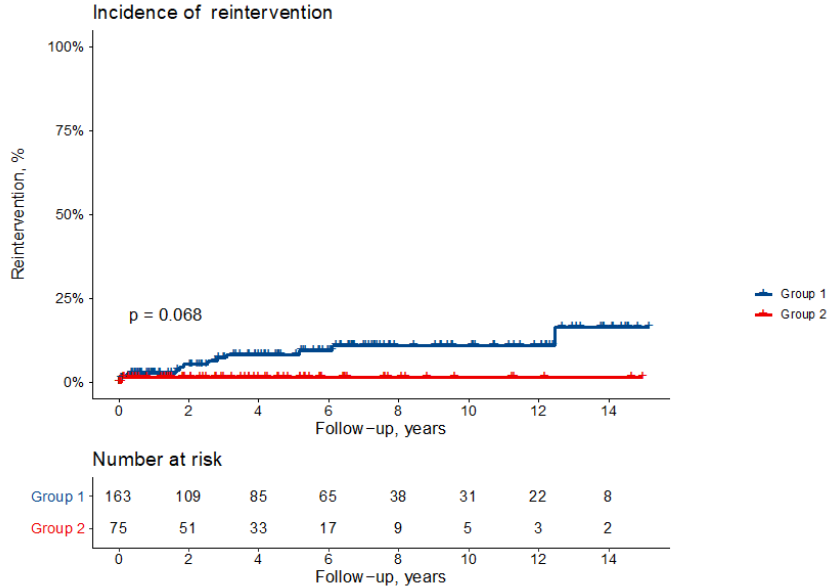
Figure 3. Cumulative incidence of reintervention (all-cause death as competing risk) according to the study group: hemiarch replacement (Group 1) or arch replacement (Group 2).